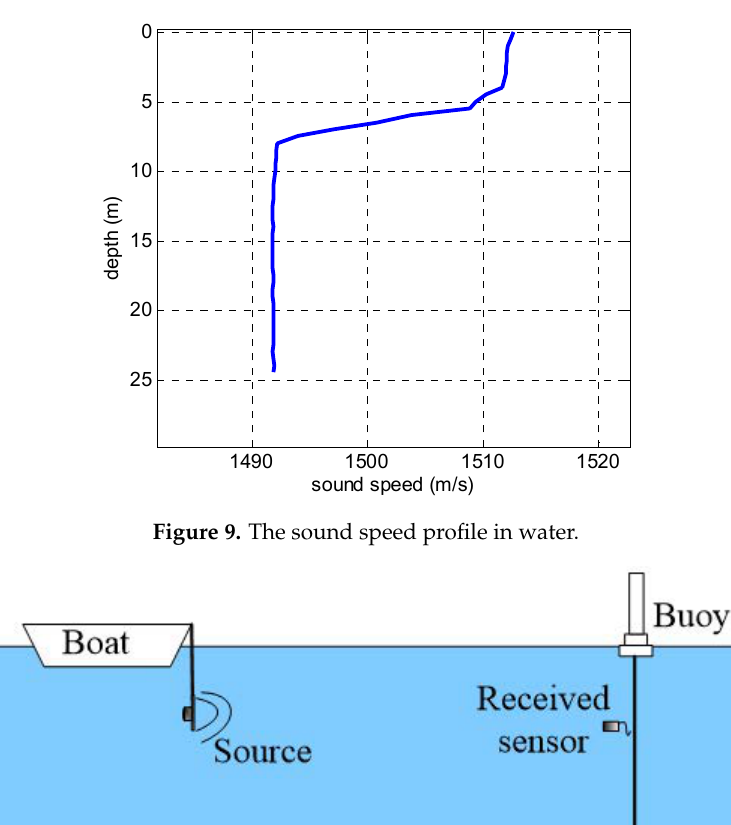
Figure 10. The sound speed profile in water.